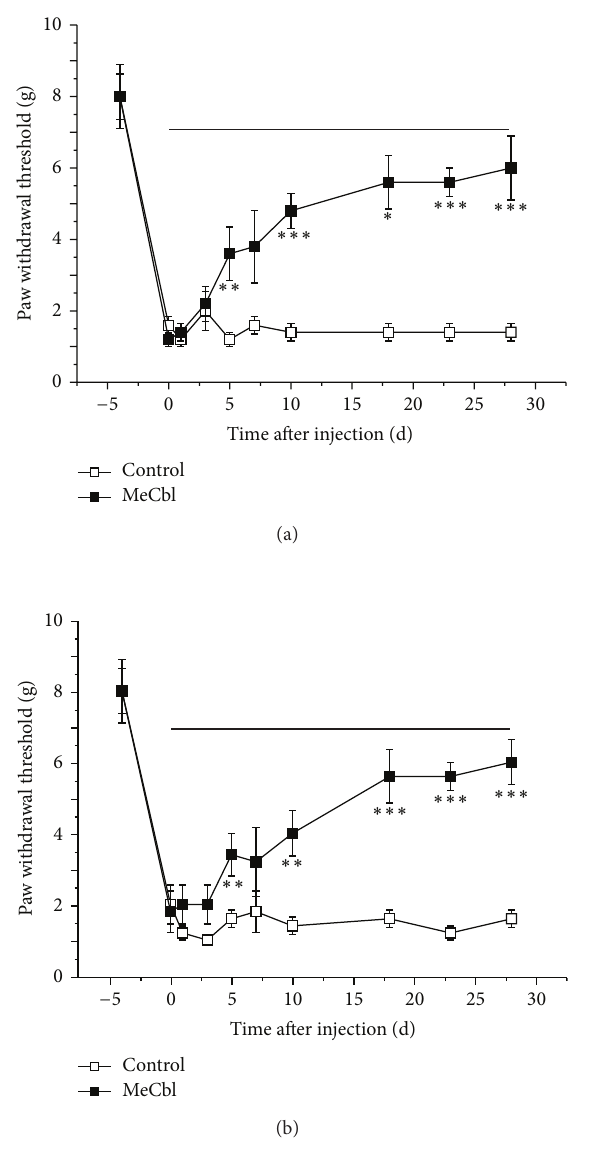
Figure2:Ananti-allodyniceffectofMeCbl.MeCblwassuccessively received by intraperitoneal injections from the 3rd postoperative day (line segment). Bilateral paw withdrawal thresholds to von Frey filaments were decreased following a long-term application of MeCb1. (a) Ipsilateral side and (b) contralateral side. ( ∗ 𝑃 < 0.05 , ∗∗ 𝑃 < 0.01 , ∗∗∗ 𝑃 < 0.001 , multivariate analysis of variance).